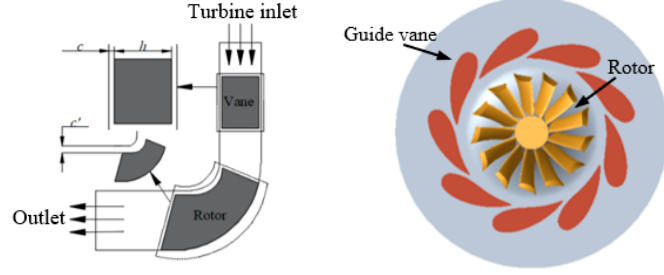
Figure 1. Meridian and three-dimensional view of the base model. Table 1. Parameters of the base model.